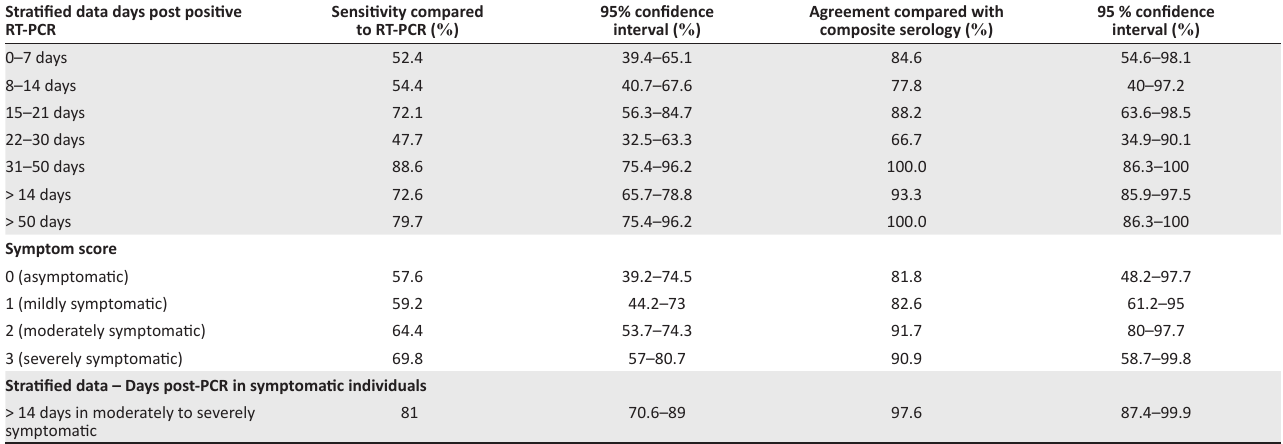
TABLE 2: Sensitivity of stratified data – Days post positive reverse transcriptase polymerase chain reaction and symptoms, compared to reverse transcriptase polymerase chain reaction and agreement compared with composite serology. Stratified data days post positive RT-PCR